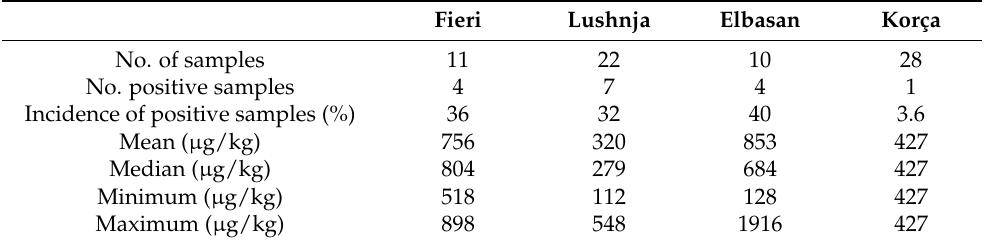
Table 3. The occurrence of DON in the wheat samples from the harvesting seasons 2014 and 2015 according to the